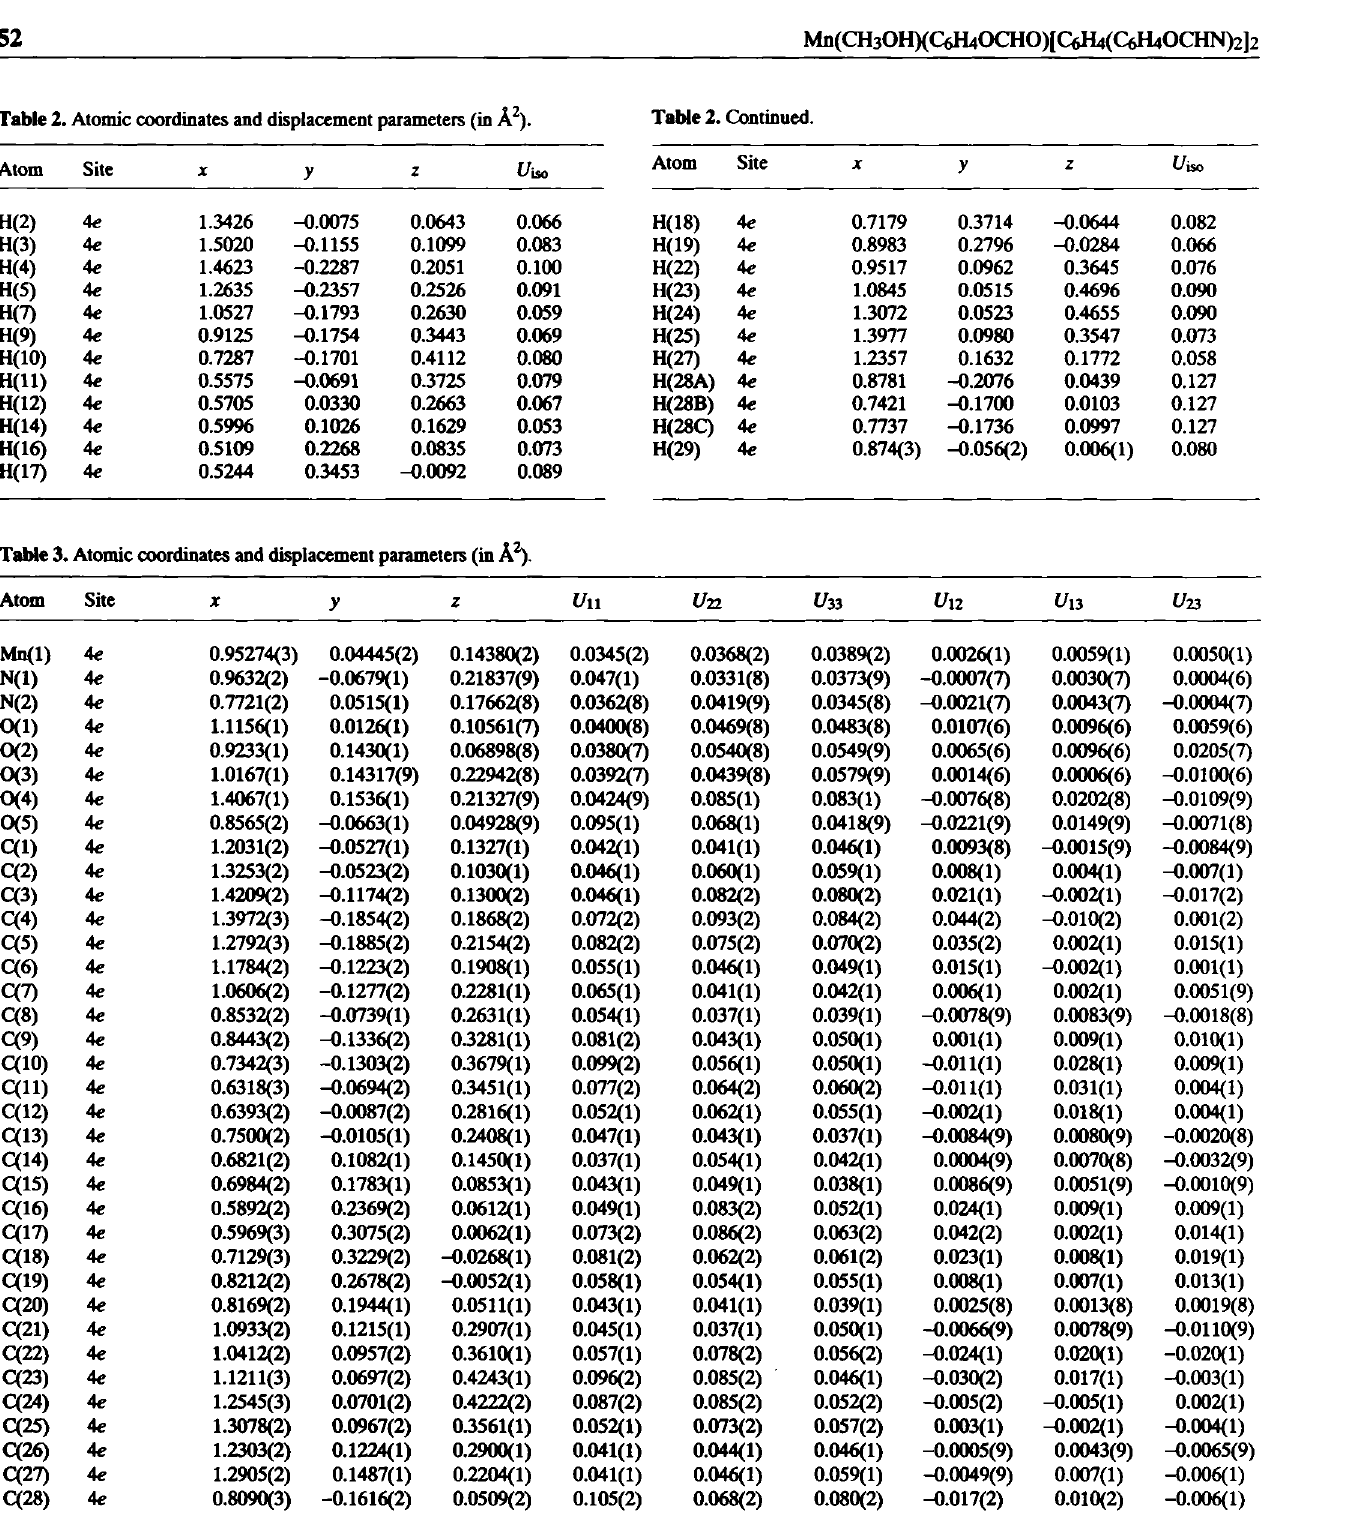
Table 2. Atomic coordinates and displacement parameters (in Ä 2 ). Table 2. Continued.